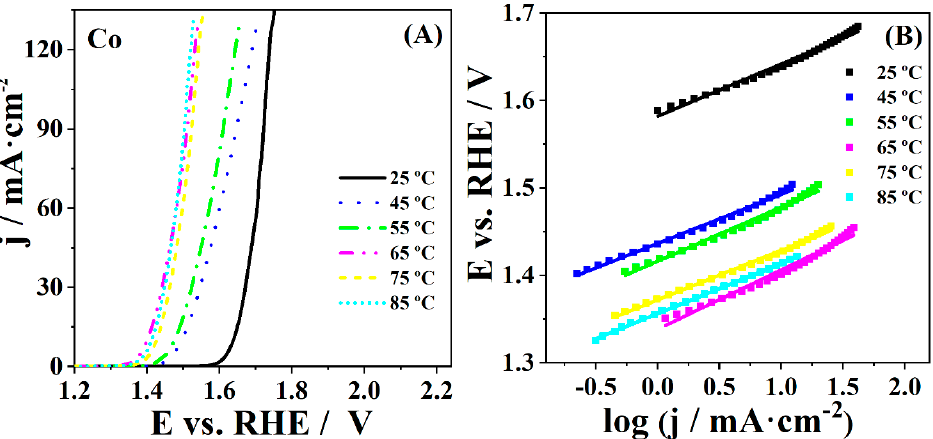
Figure 5. ( A ) OER polarization curves of Co coating in 1 M KOH recorded at polarization rate of 5 mV·s − 1 at different temperatures with ( B ) corresponding Tafel plots.